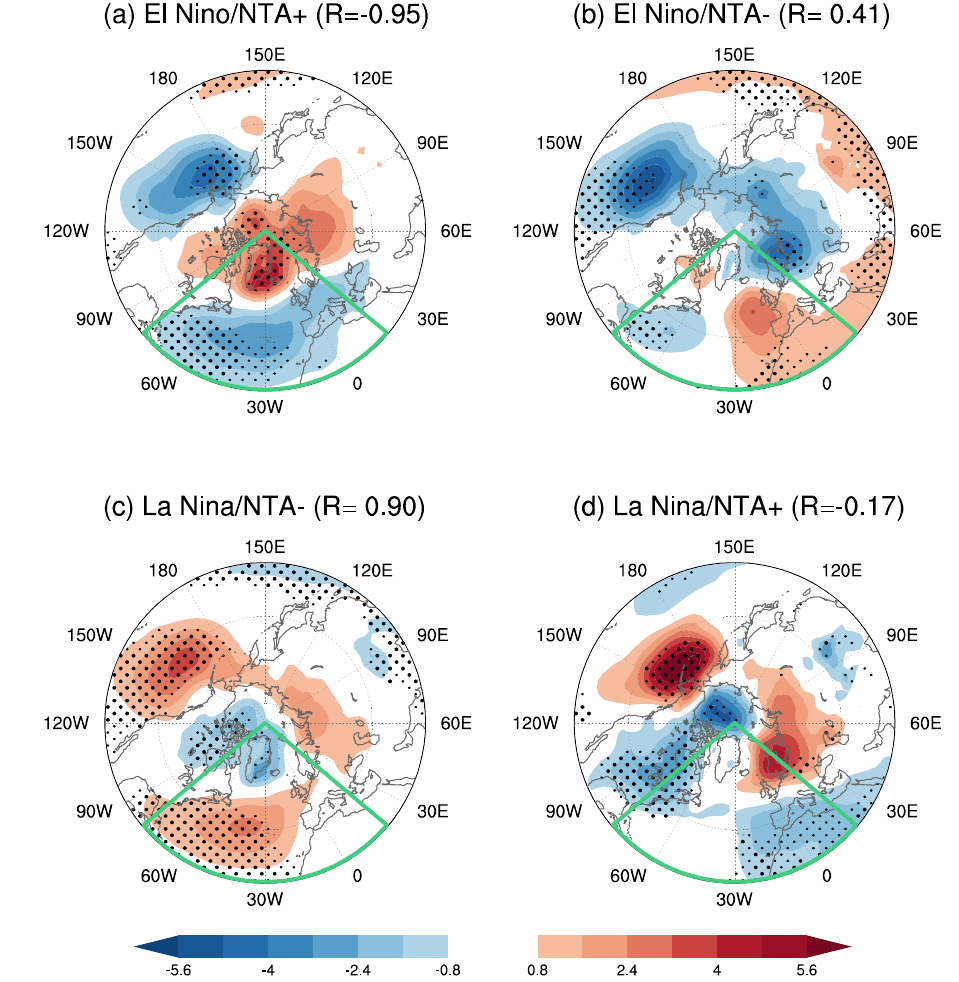
Figure 8. Composite SLP anomalies (hPa) for ( a ) El Niño events concurrent with positive NTA SST anomalies; ( b ) El Niño events concurrent with negative NTA SST anomalies; ( c ) La Niña events concurrent with negative NTA SST anomalies; and ( d ) La Niña events concurrent with positive NTA SST anomalies. Large (small) dots indicate regression coefficients that are statistically significant at the 95% (90%) confidence level. The green box indicates the North Atlantic region (20°–90° N, 0°–80° W).